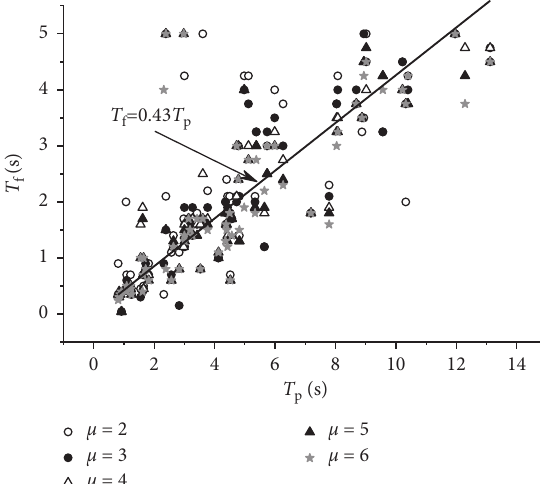
Figure 6: Scatter plot of T